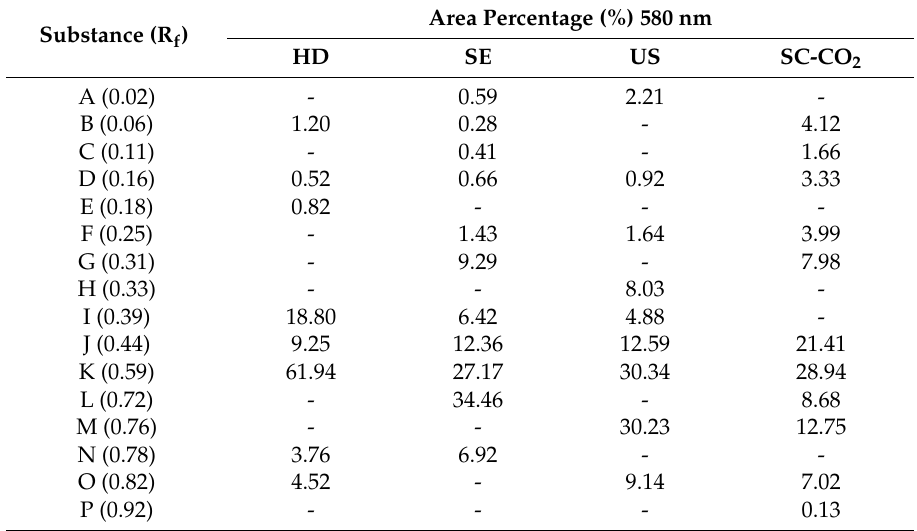
Table 4. Substance A–P with their R f and area percentage of T. ammi essential oil obtained by different extraction